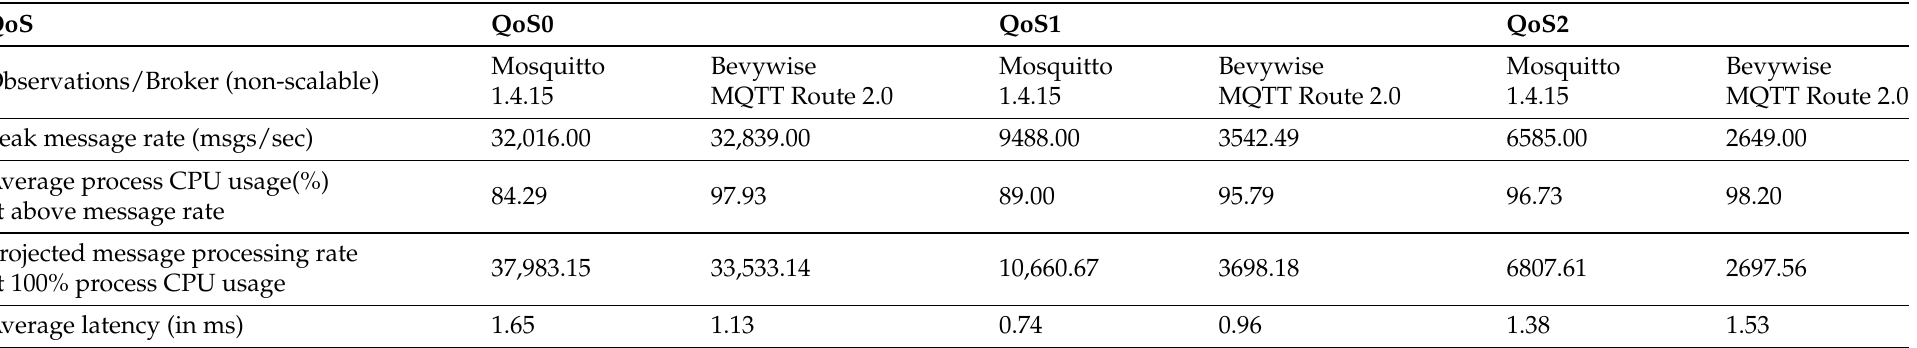
Table 6. Projected message processing rates of non-scalable brokers at 100% process CPU usage (local test results). Mosquitto and Bevywise are fixed thread/single thread broker implementations. They cannot scale up to use all cores available in the system.